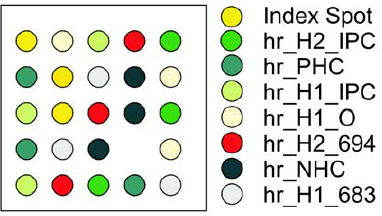
Figure 9. Capture probe array layout. The identifier and the location for the binding side of each reporter probe is indicated. Besides the specific probes for HIV-1 (hr_H1_683), HIV1_O (hr_H1_O) and HIV-2 (hr_H2_694) amplicons, the array contains a positive hybridization control (hr_PHC) and a negative hybridization control (hr_NHC) to assure correct hybridization performance. Moreover, internal process controls for HIV- 1 (hr_H1_IPC) and HIV-2 (hr_H2_IPC) are implemented to confirm amplification performance.